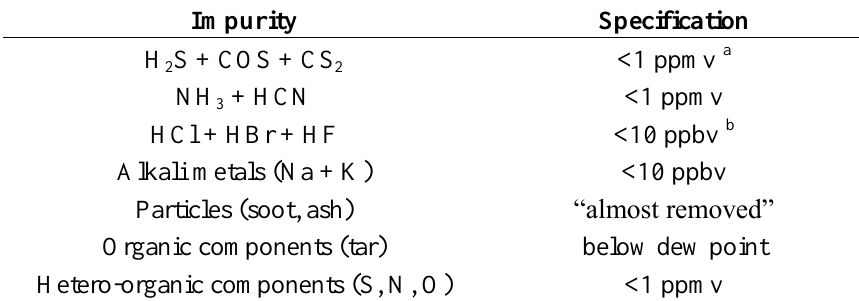
Table 4. The requirements of syngas cleaning for Fischer–Tropsch synthesis